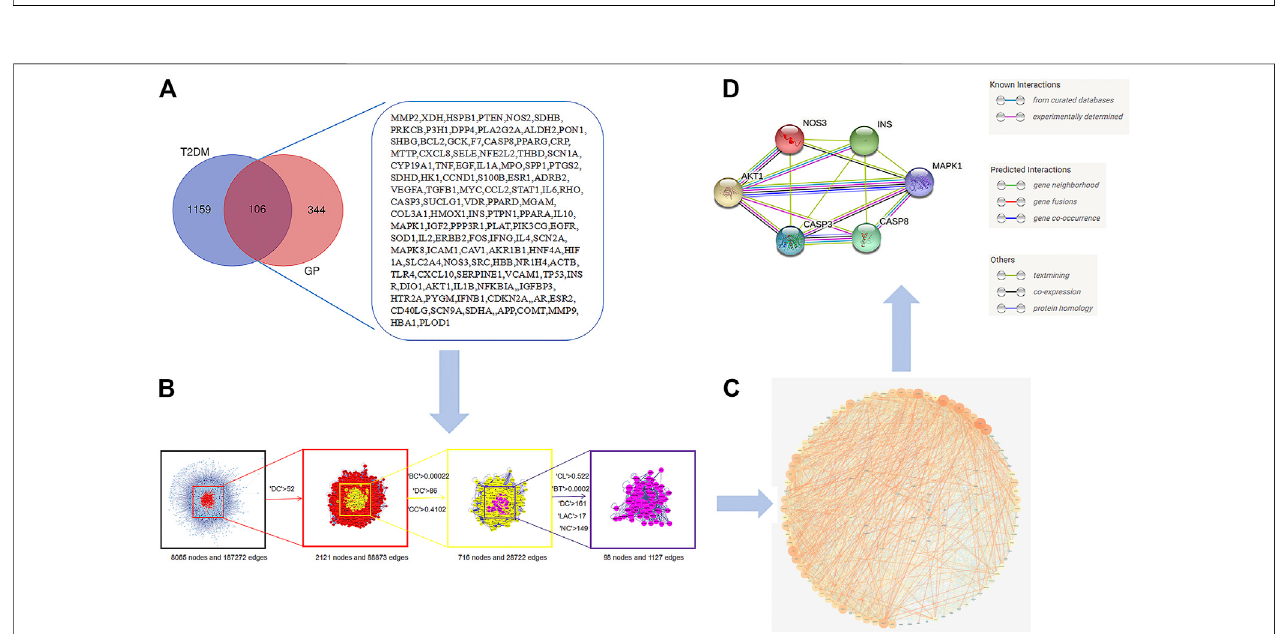
FIGURE4| Hubgenesof Gynuraprocumbens (GP)andtypeIIdiabetesmellitus(T2DM). (A) Venndiagramandcandidatetargetsof Gynuraprocumbens (GP)and type IIdiabetesmellitus(T2DM), (B) arget fi ltering strategydiagram ofhubnodes (degree centrality (DC),betweennesscentrality(BC),closeness centrality (CC), network centrality (NC), local average connectivity (LAC)), (C) protein – protein interaction (PPI) network, and (D) Network of the top six hub genes.